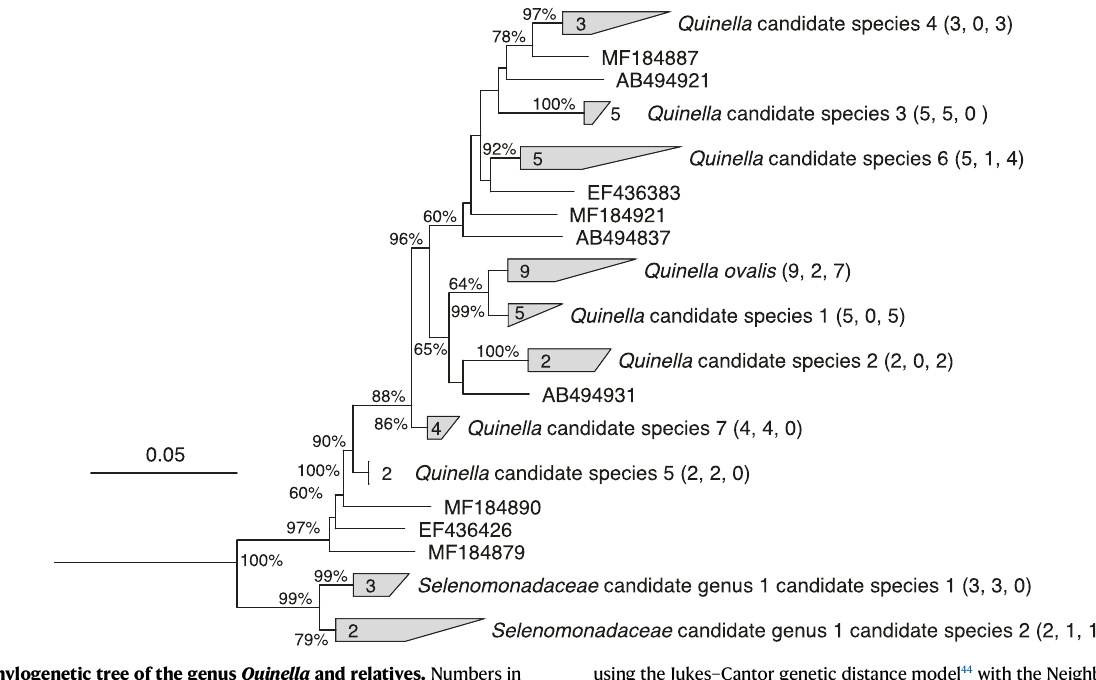
using the Jukes – Cantor genetic distance model 44 with the Neighbor-Joining method 45 , implemented in ARB 42 . The numbers at the nodes are the percentage of trees thatconserved thatnodein 1000 bootstrap resamplings. The 16S rRNA gene sequence of Fibrobacter succinogenes (GenBank accession CP002158) was used as an out-group sequence. The scale bar represents 0.05 changes per nucleotide